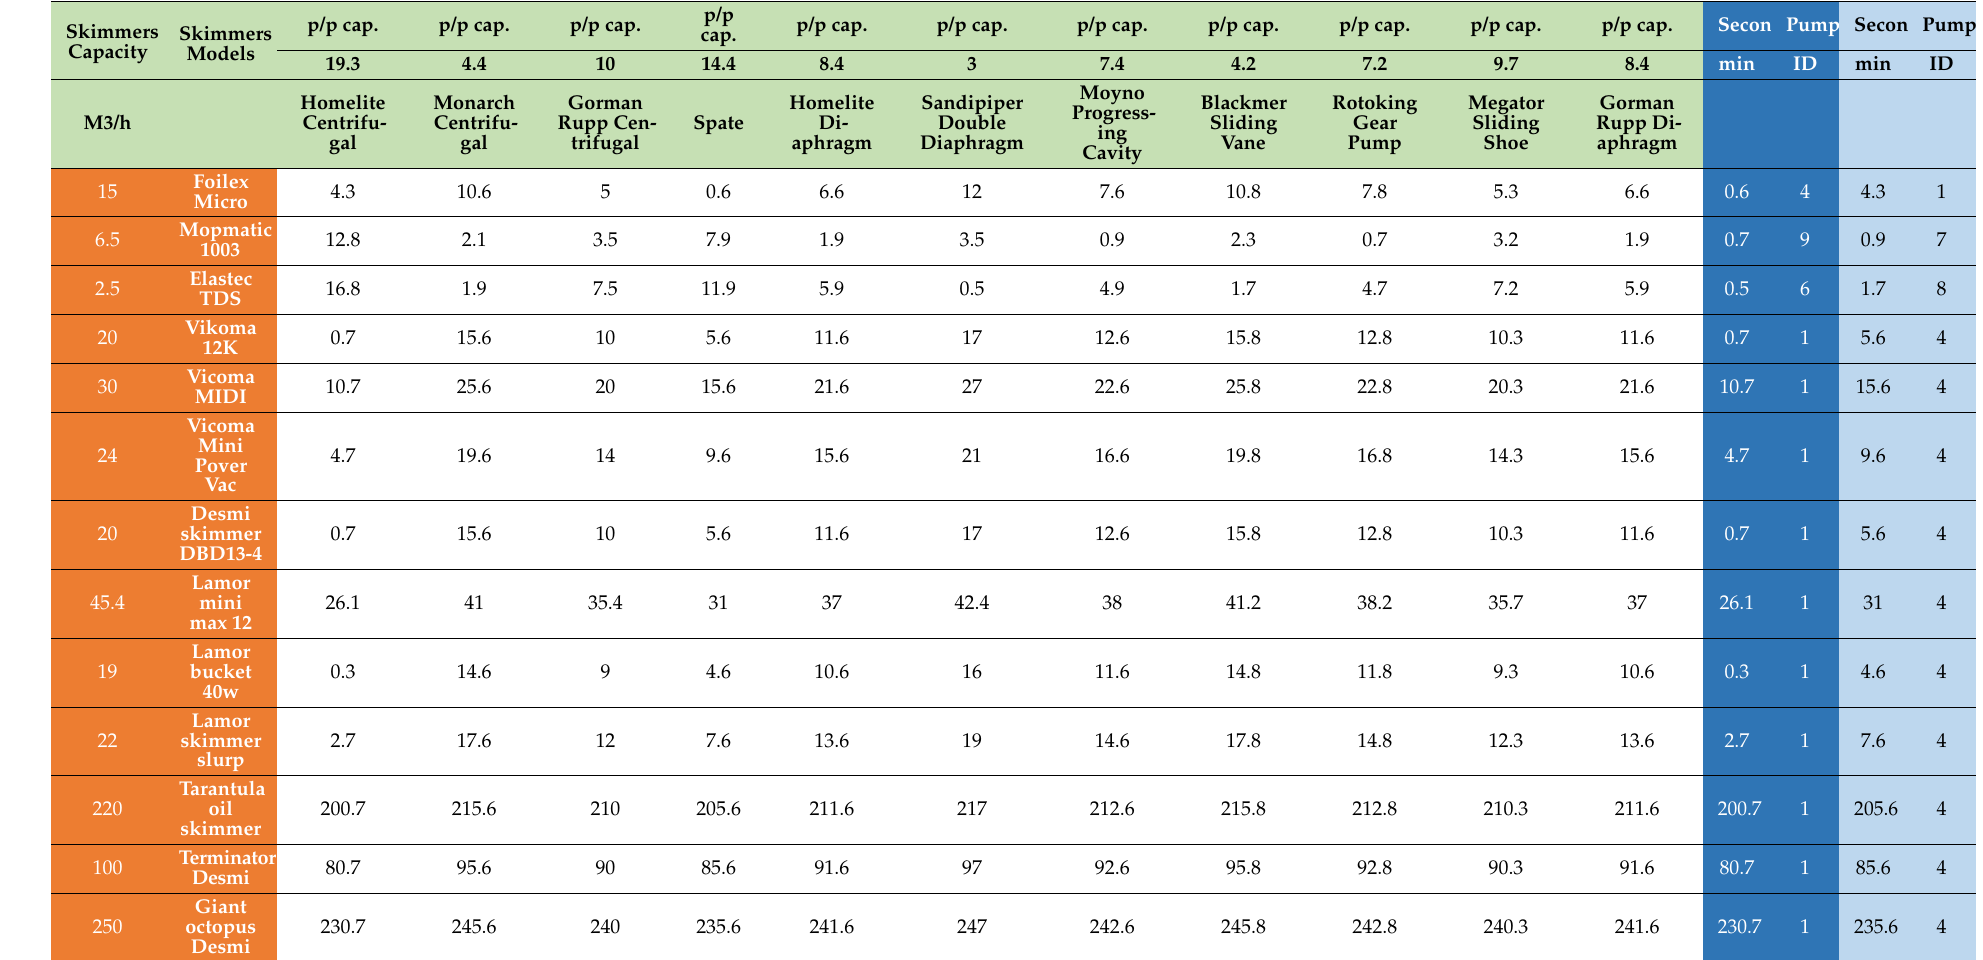
Table 2. The difference in the efficiency of skimmers with